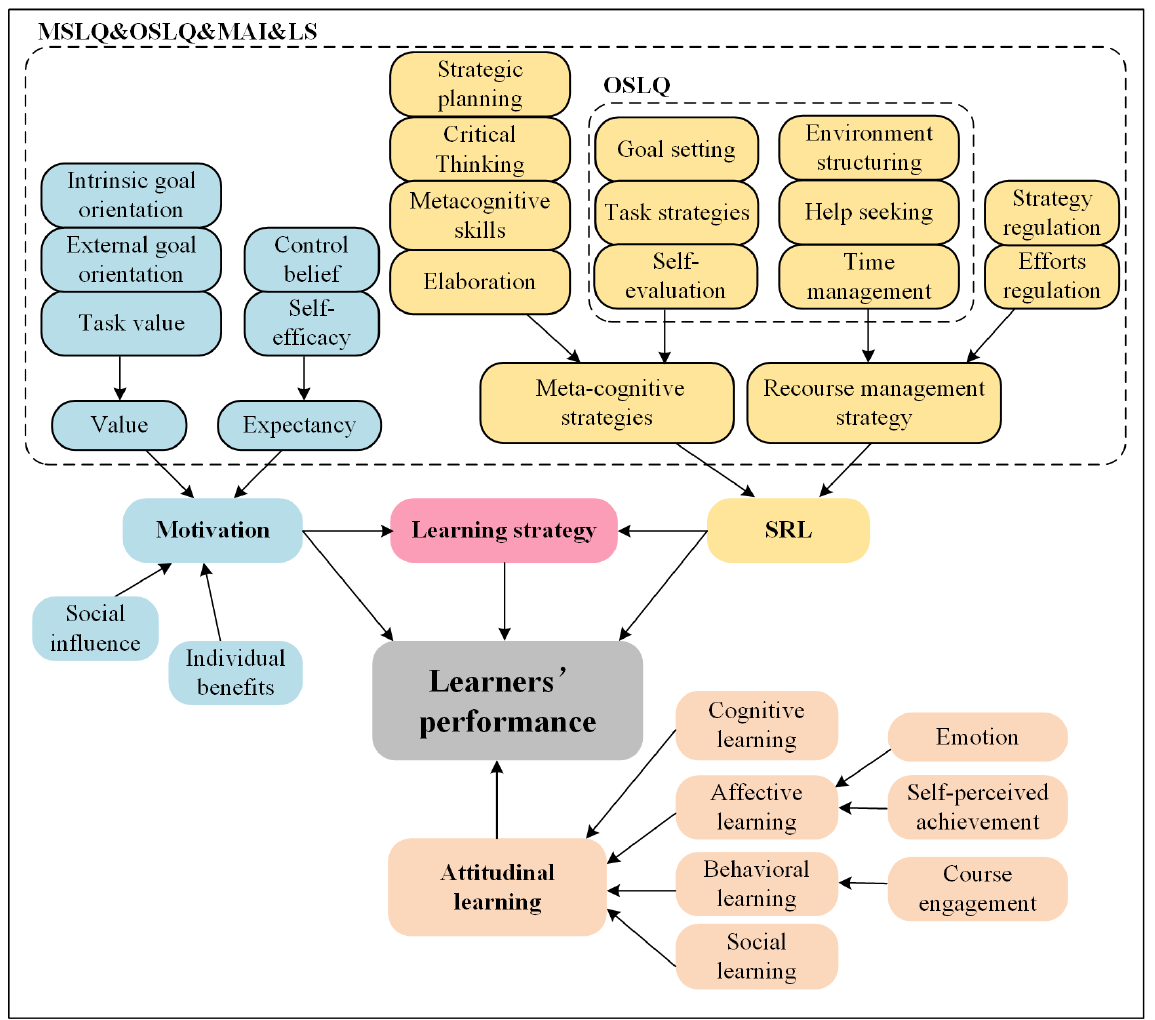
Figure 2 F-G Graph: Factors Affecting Learners’ Performance in